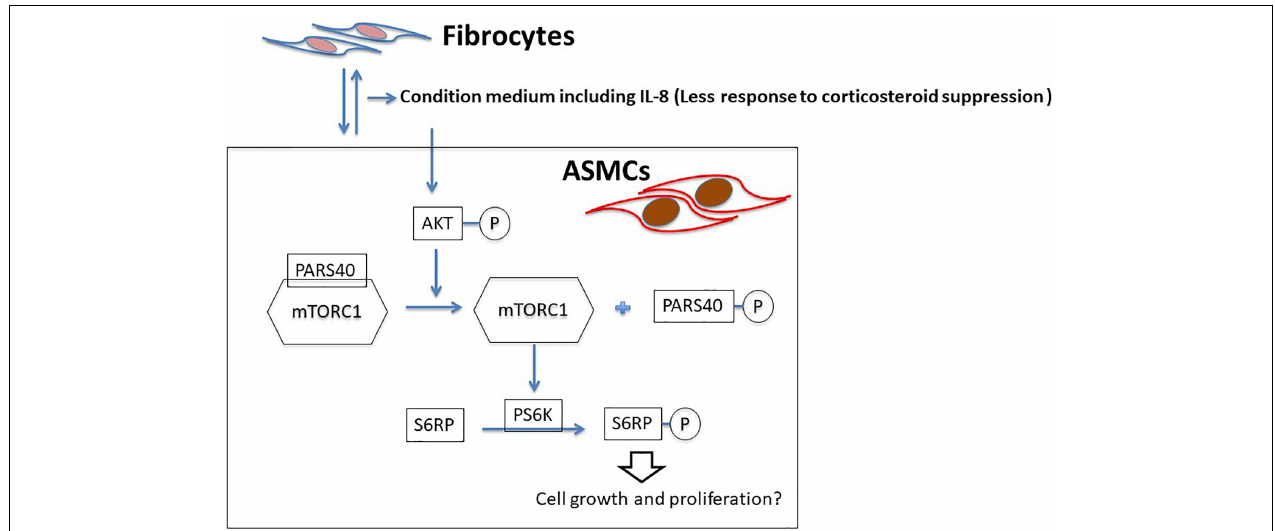
FIGURE 7 | Proposed model of ASMC remodeling by fibrocytes in asthma patients via the axis of IL-8-AKT-PARS40-mTORC1. Interaction between fibrocytes and ASMCs increases the production of IL-8 in asthmatic airways, and corticosteroid-induced suppression of IL-8 production is reduced. IL-8 stimulation activating the axis of AKT-PARS40-mTORC1 in ASMC may contribute the downstream processes involved in ASMC proliferation/growth.